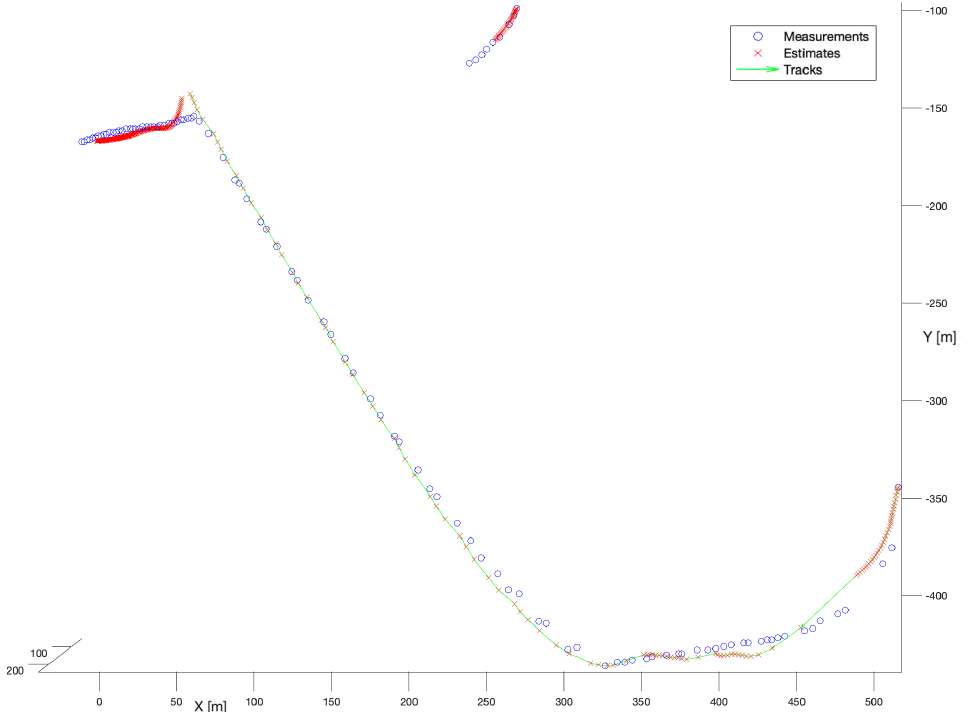
Figure 13. Interacting Multiple Model + Joint Probabilistic Data Association. Multiple bird flight